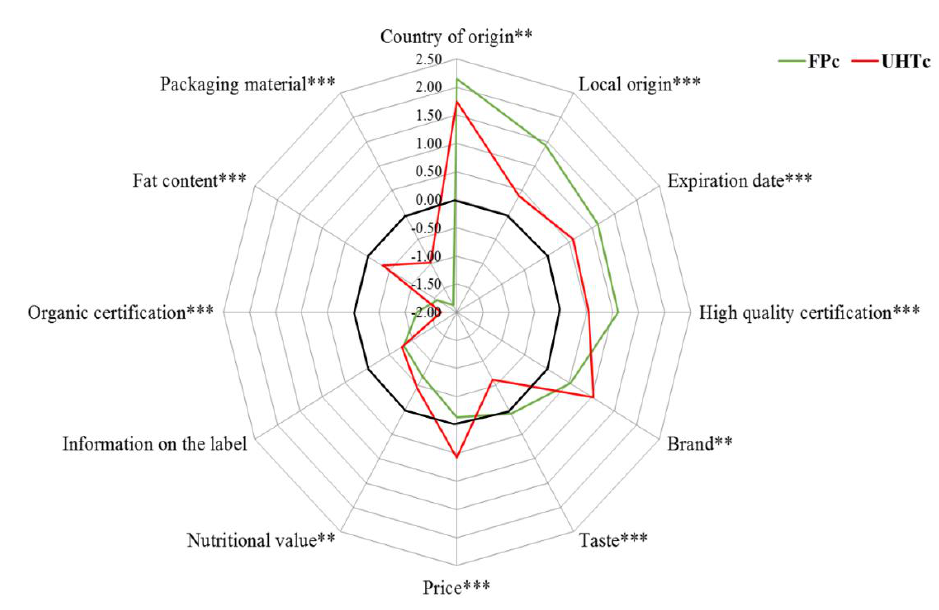
Figure 1. Level of importance (average raw scores) given by the FP and UHT milk consumers to the 12 milk quality attributes. Notes: the differences between the average raw scores for each milk attribute between the two consumers’ groups tested through the Mann-Whitney U test were significant at the 5% (**) and at the 1% level (***).